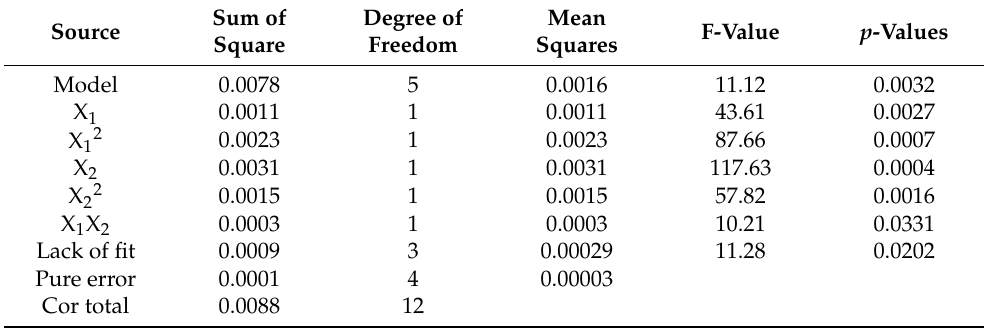
Table 9. Variance analysis of regression equation Y